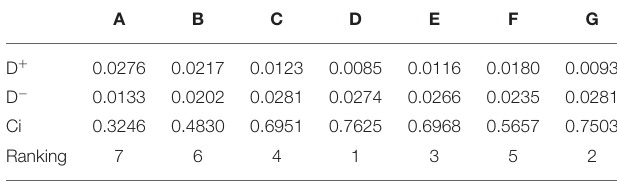
TABLE 5 | Overall ranking of laboratory management.